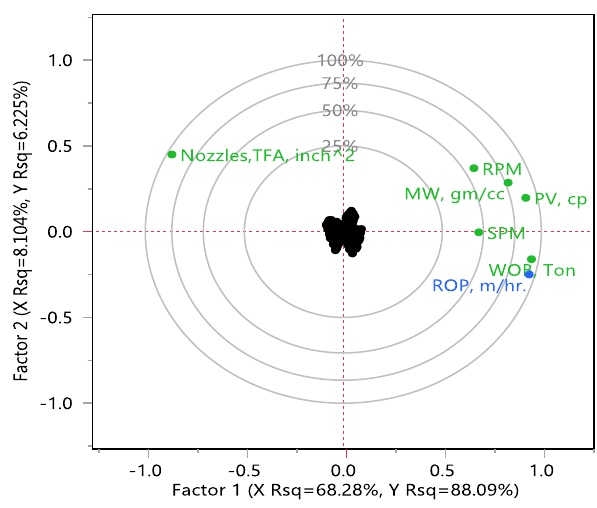
Fig. 27 Correlation loading plot of ROP